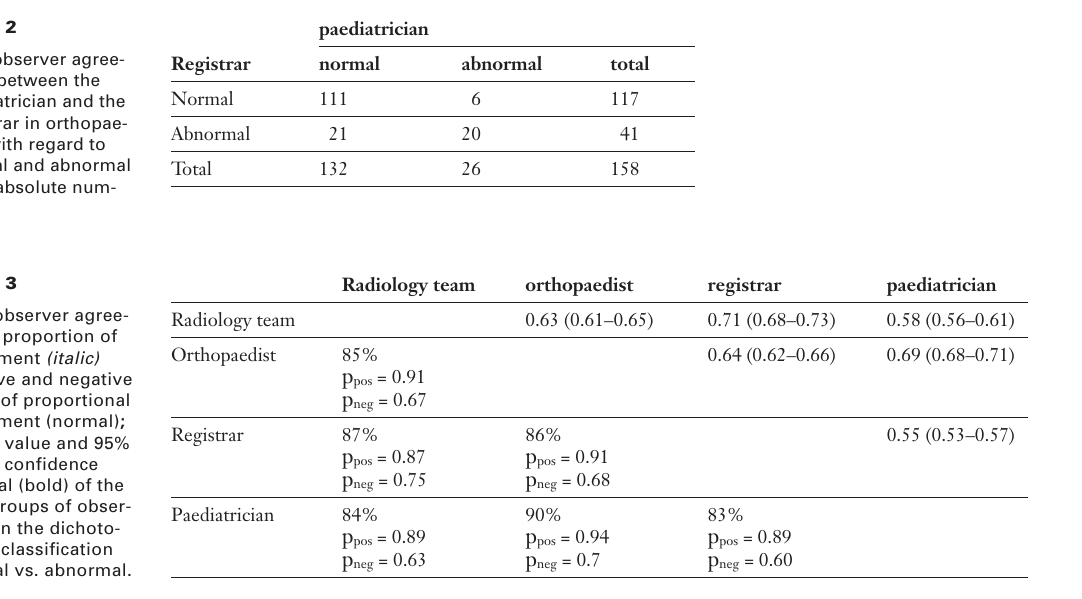
Distribution of Graf classification of 158 ultrasonograms by four observers with regard to normal, im- mature, dysplasia and dislocation hip type.